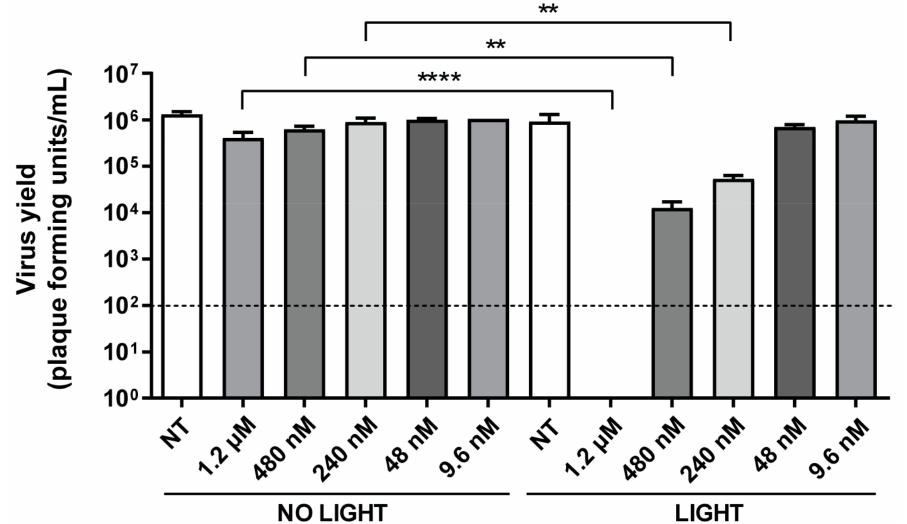
Figure 5. Light-activated TMPyP3-C 17 H 35 inhibits HSV-1 infection at nM concentrations. Vero cells were infected after treatment with TMPyP3-C 17 H 35 at concentrations between 9.6 nM and 1.2 µ M, with or without irradiation. After 18 h of infection, supernatants were collected and the number of plaque-forming units (Pfu) determined by titration. NT: not treated. All samples were tested in triplicate, and data were analyzed using unpaired t-test ( p values indicate significant differences; **** p = 0.0001, ** p = 0.0048). Dashed line in the graph represents detection limit of the experiment of 100